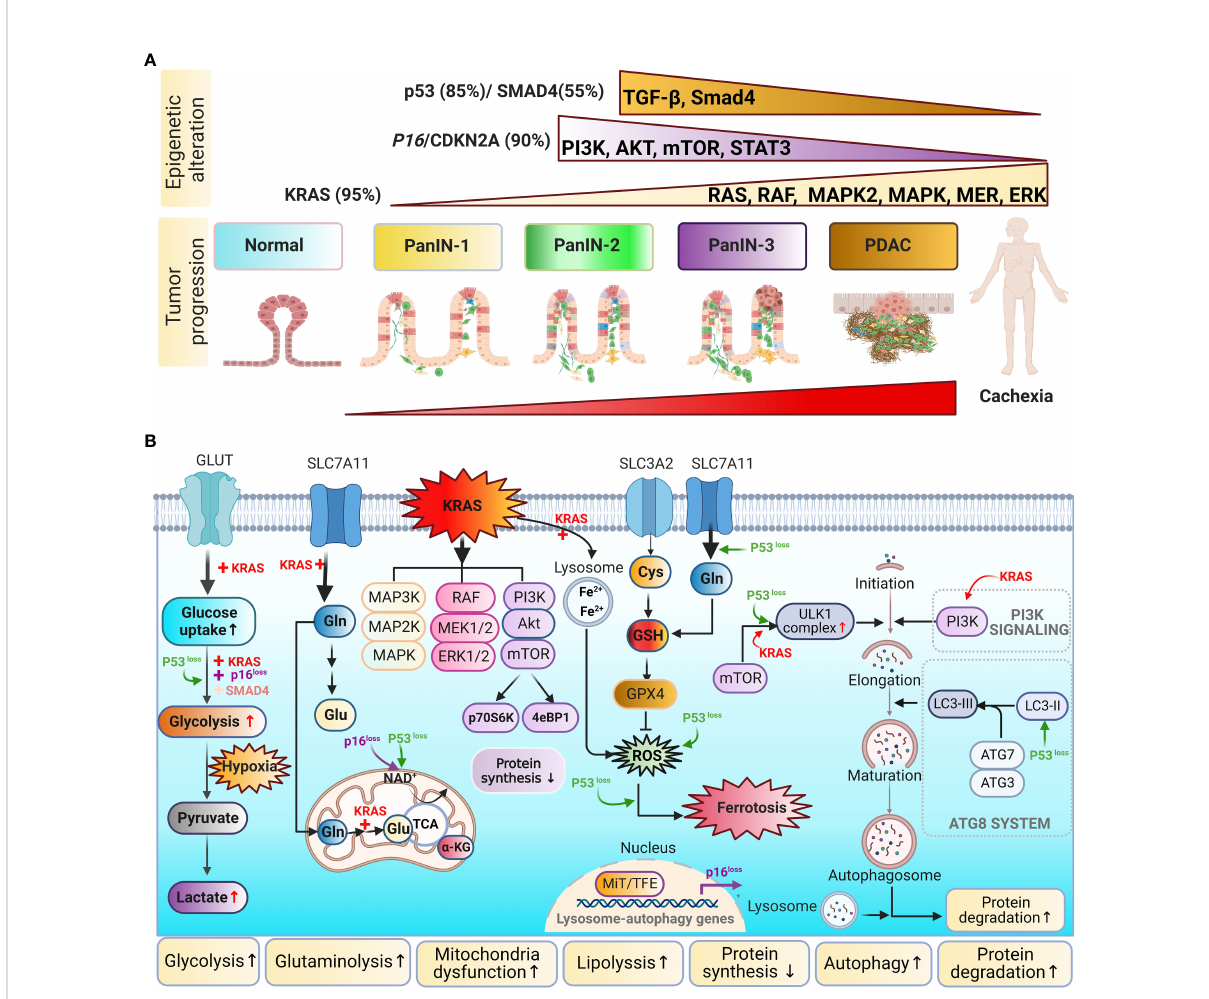
FIGURE 4 Metabolic remolding is in fl uenced by genetic instability in PDAC. (A) Genetic mutations: PDAC is affected by high frequencies of aberrations and mutations in KRAS , P16/CDKN2A , TP53 , and SMAD4 . KRAS is involved in the RAF/mitogen-associated protein kinase pathway and the phosphoinositol 3-kinase (PI3K) pathway. P16/CDKN2 mediates the PI3K/AKT/mTOR pathway. TP53 in fl uences the transforming growth factor- beta (TGF- b )/Smad4 pathway. (B) Mutated forms of KRAS , TP53 , P16/CDKN2 , and SMAD4 promote glucose (Glc) uptake and enhance glycolytic fl ux, including the production of lactate (Lac). KRAS and TP53 can both reprogram glutamine (Gln) metabolism to balance cellular redox homeostasis. Pancreatic cancer induces metabolic shifts, including increased glycolysis, lipogenesis, glutaminolysis, and autophagy, which are related to